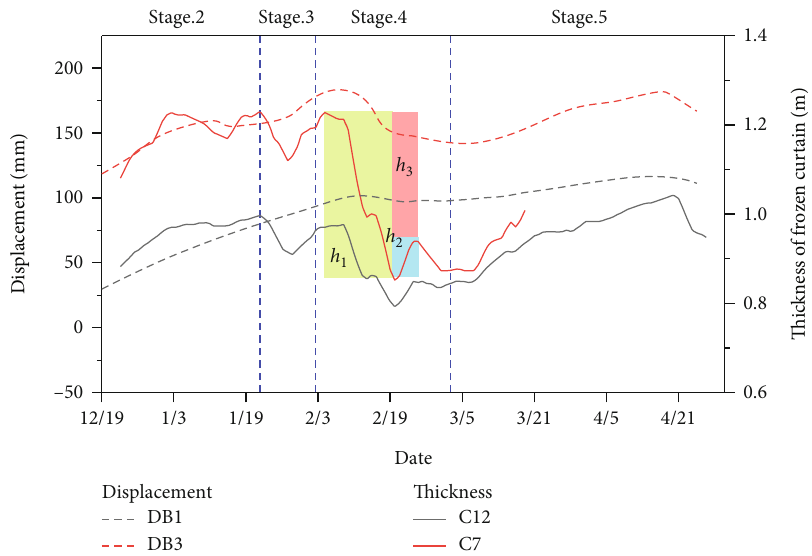
Figure 11: Scheme of frozen curtain thickness and ground displacement.